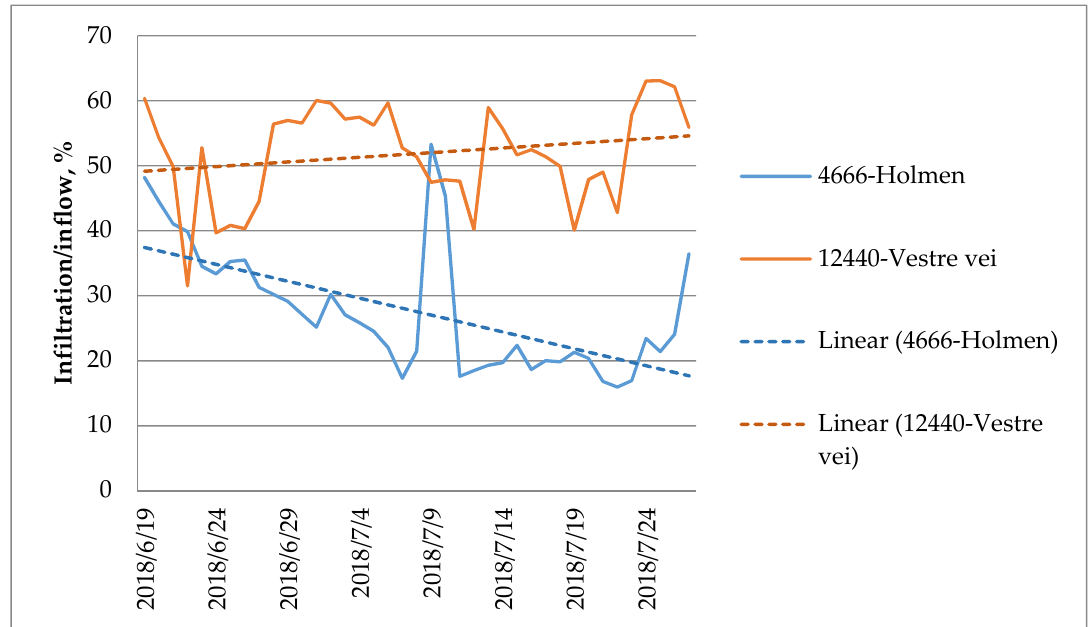
Figure 7. Calculated share of I/I-water in a dry weather period, before the implementation of the measures.